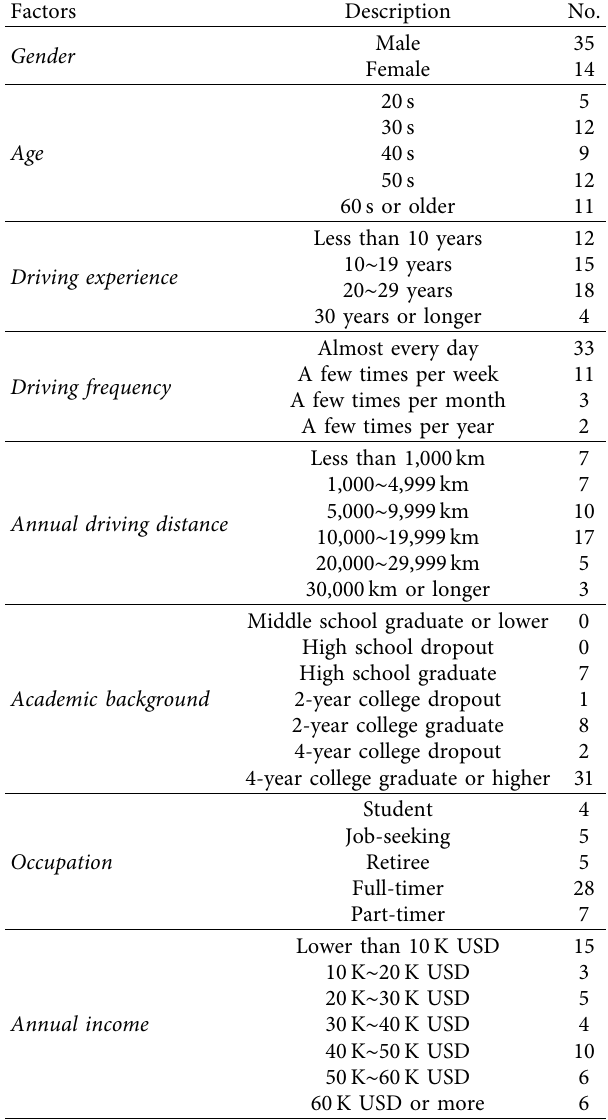
Table 1: Composition of experiment